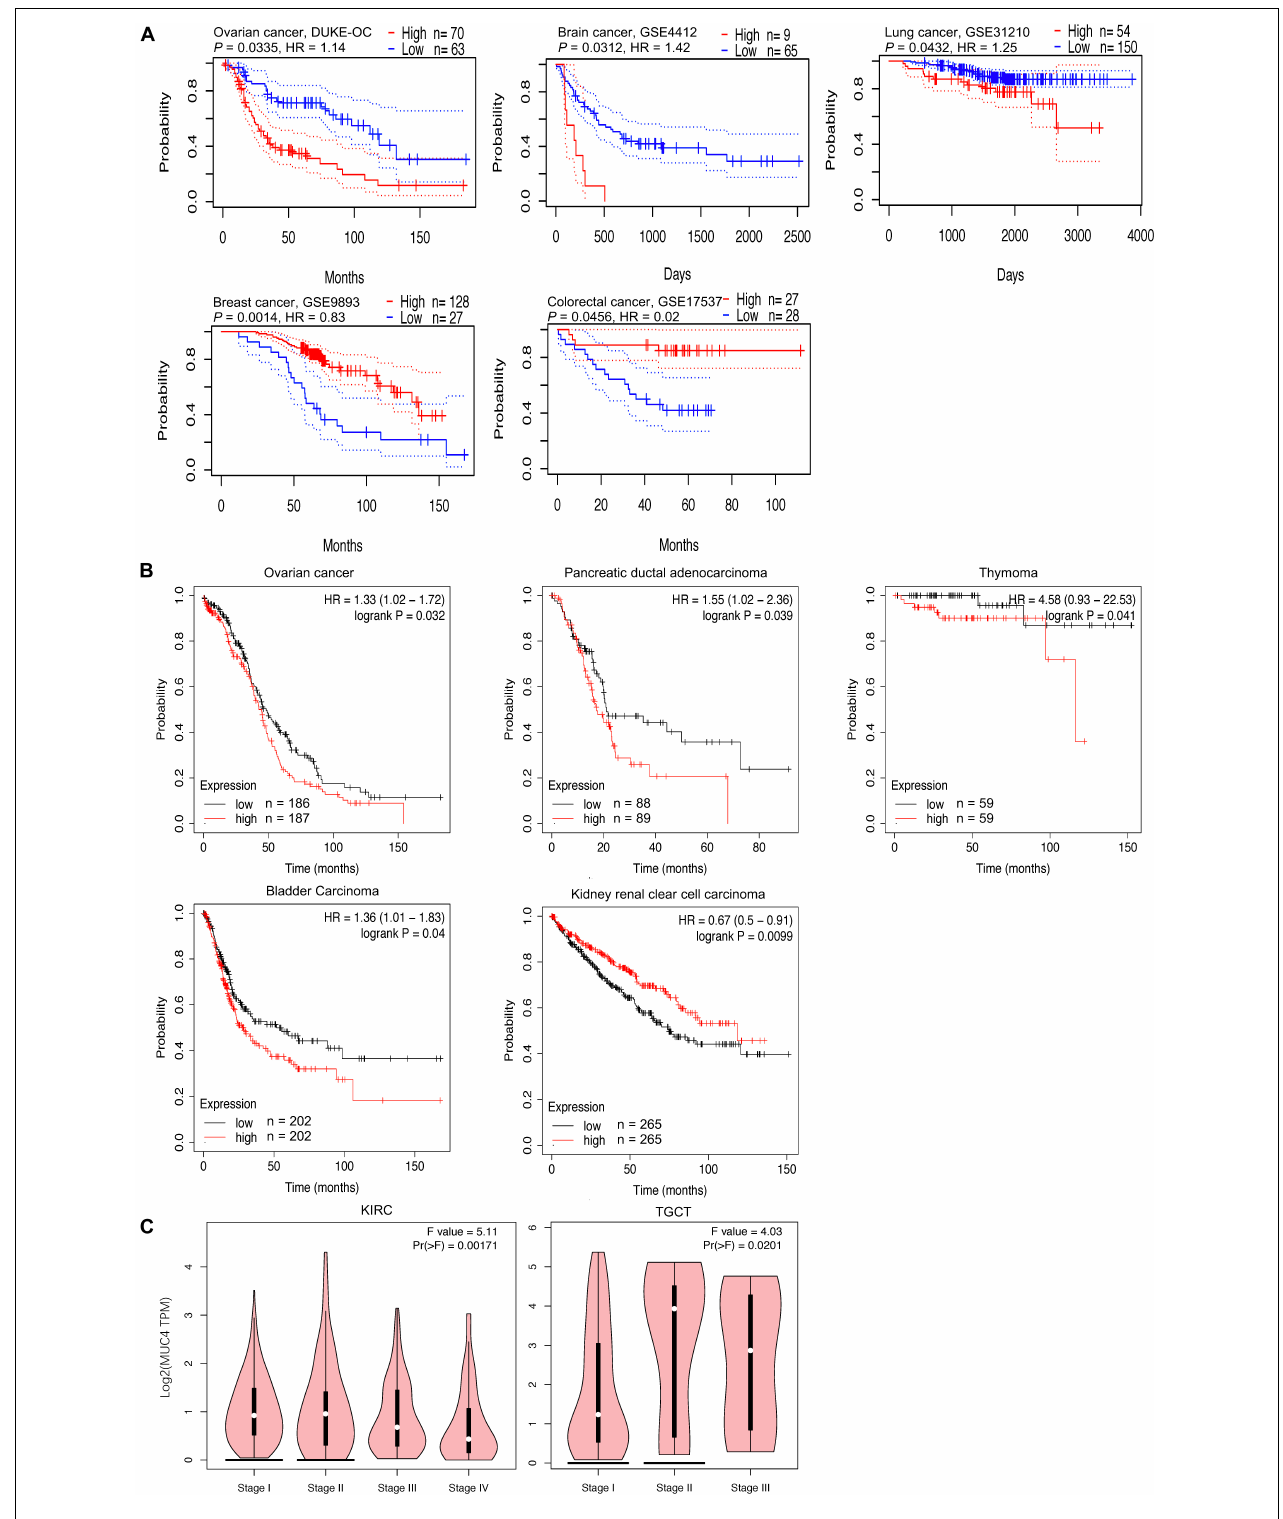
FIGURE 2 | Overall survival curves comparing the high and low expression of MUC4 and pathological stage plot across different cancer types. (A,B) Kaplan–Meier plot in PrognoScan panel (A) and Kaplan–Meier Plotter panel (B) . The X-axis represents time, and the Y-axis represents survival rate. Ninety-five percent confidence intervals for each group are also indicated by dotted lines from PrognoScan. (C) Expression violin plot based on patient pathological stage in GEPIA2. HR, hazard ratio.